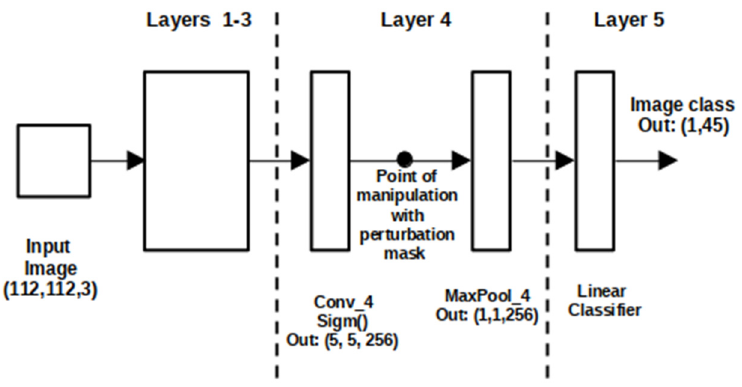
Figure 2. CNN PRYSTINE manipulations with perturbation mask in 4-layer architecture.